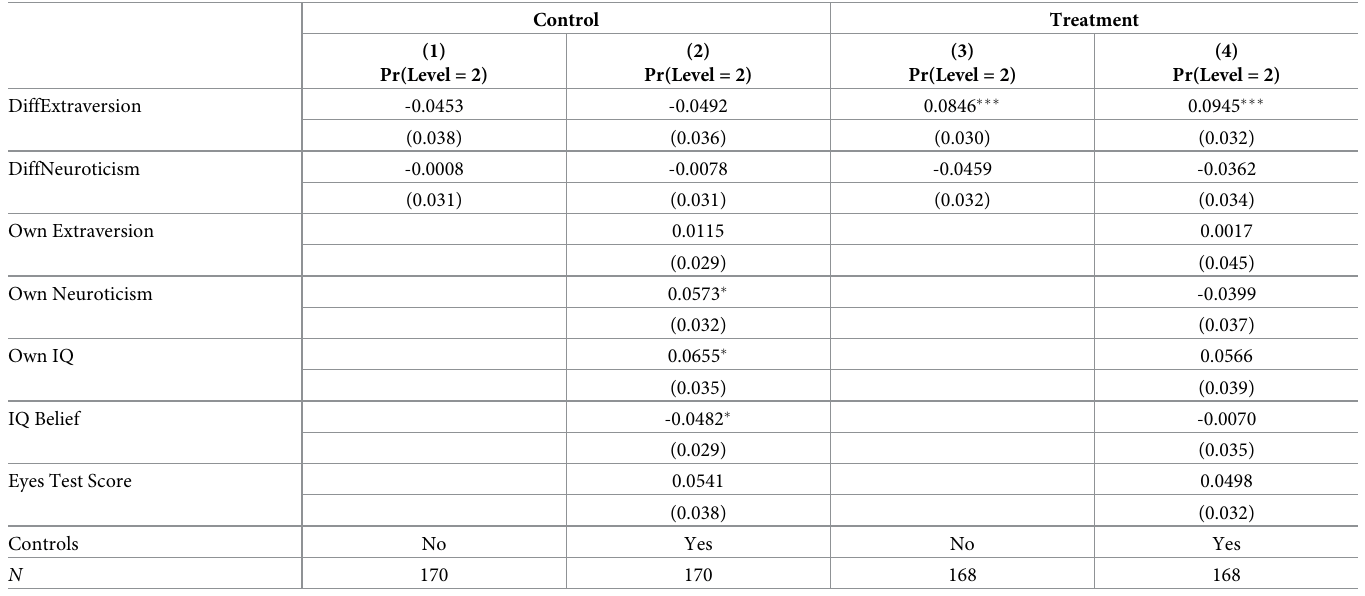
Table 5. Impact of (absolute) difference between own personality and beliefs about partner’s personality on the probability of choosing the best response—Probit model.